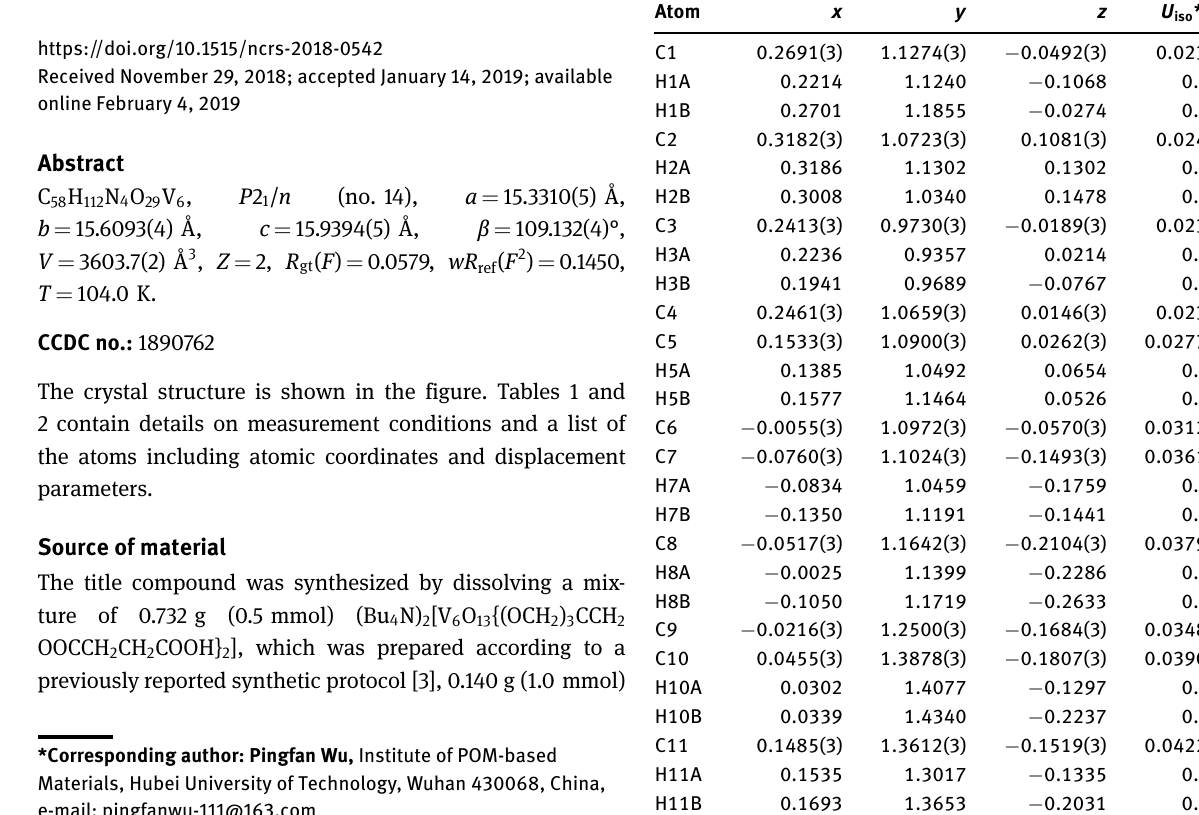
Table 2: Fractional atomic coordinates and isotropic or equivalent isotropic displacement parameters (Å 2